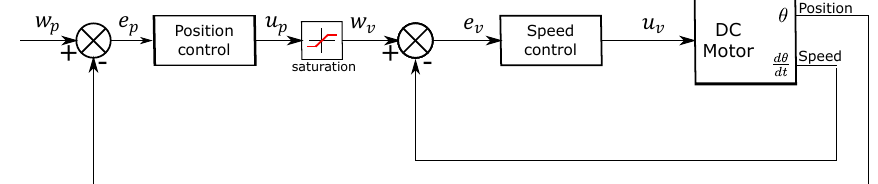
Figure 9. Diagram block for the motors PID controller.